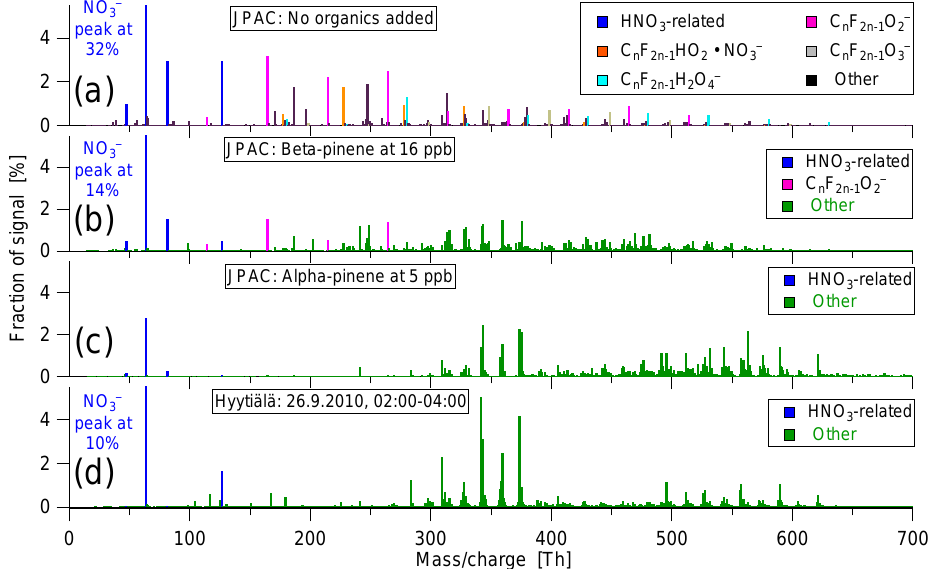
Fig. 1. Negative ion spectra from the JPAC at three different chamber conditions ( (a) : no addition, (b) : β -pinene added, (c) : α -pinene added) and from Hyyti¨al¨a (d) . The NO − signal is allowed to go off scale in (a) , (b) , and (d) . In these cases the peak values are written out 3